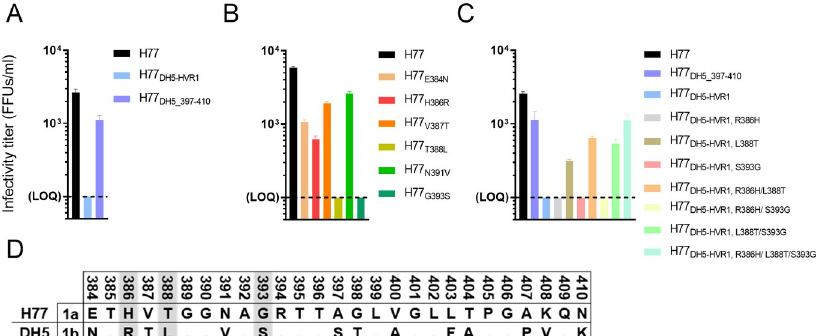
Fig 4. Infectivity of H77 DH5-HVR1 is restored by introducing the H77 residue at the N-terminal HVR1 positions 386, 388 and 393. (A-C) Huh7.5 cells were transfected with in vitro transcribed HCV RNA of the indicated recombinants. Supernatants were collected 24, 48, 72 and 96 hours post transfection, and HCV infectivity titers were determined. The infectivity titers of the recombinants are shown at 72 hours post transfection as a mean of three technical replicates (complete data sets are shown in S1 Fig). Error bars represent standard deviation. Lower level of quantification was 100 FFU/ml. The substitutions are numbered according to H77 abs. ref. (GenBank #AF009606). (D)